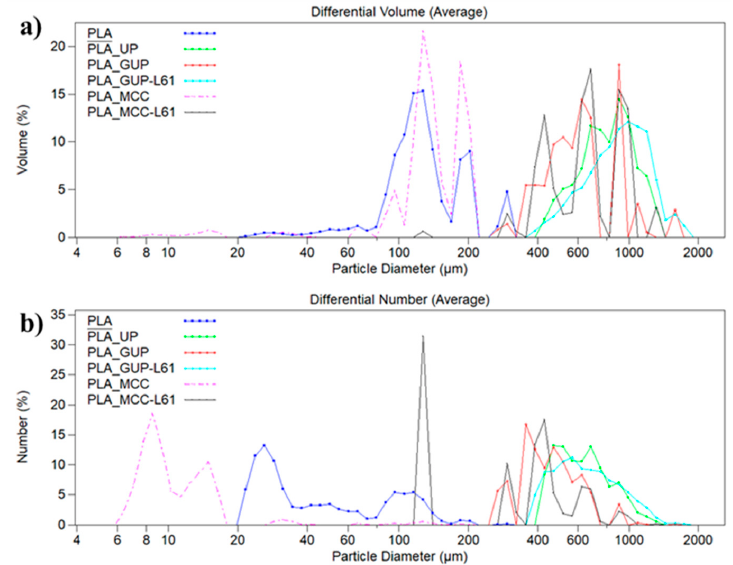
Figure 4. Particle size distributions in volume ( a ) and in number ( b ) for some PLA/cellulose biocomposite spheres (see Table 1 for abbreviations).